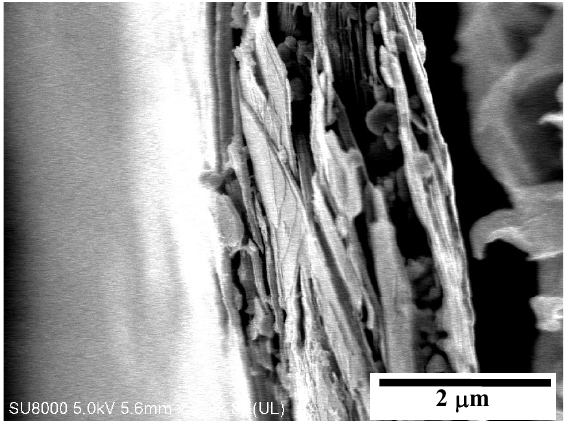
Figure 4. SEM image of talc particle observed inside the PP-T membrane cross-section.